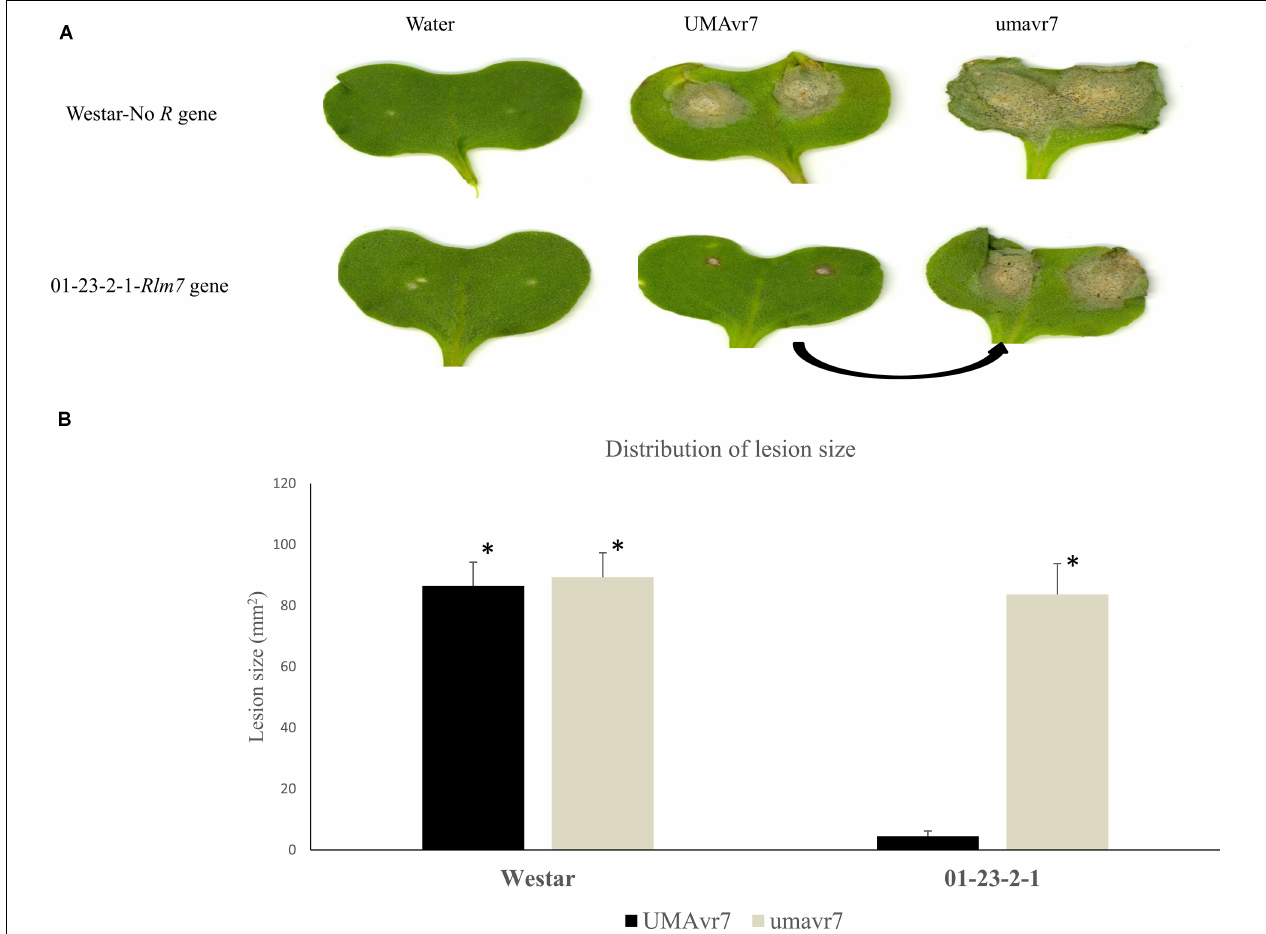
FIGURE 2 | Phenotype characterization of the wild type and its mutant isolates. (A) Disease symptoms at 11 days post-inoculation (dpi) on Westar and 01-23-2-1 cotyledons inoculated with water, wild type isolate (UMAvr7) and the mutant isolate (umavr7). (B) Pathogenicity tests between wild type isolate and mutant isolate on susceptible (Westar) and resistant genotype (01-23-2-1), respectively. Each bar indicates the mean and standard deviation of lesion size for isolate on certain Brassica napus genotypes. The asterisk over bars represents the significant difference ( p < 0.05) of lesion size caused by the wild type and mutant